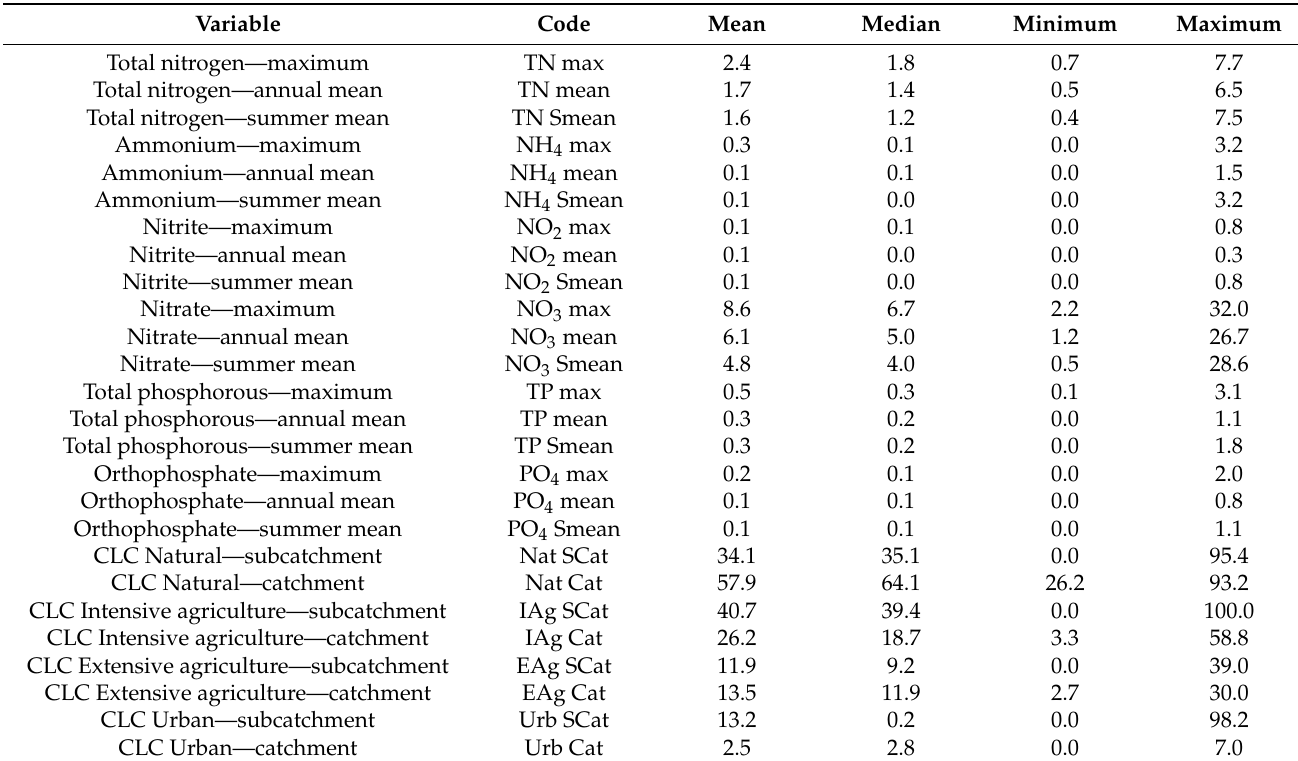
Table 1. Mean, median, minimum, and maximum values of the selected nutrient and Corine Land Cover (CLC) variables. Variable